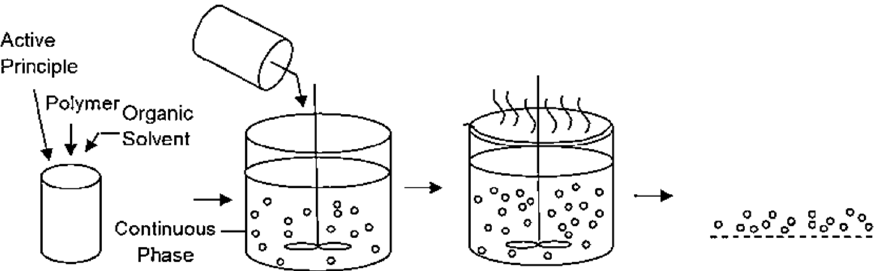
Figure 3. Solvent evaporation process. Ref [34] Reproduced with permission from Mehta et al. International Journal of Advanced Scientific Research; published by Gupta,